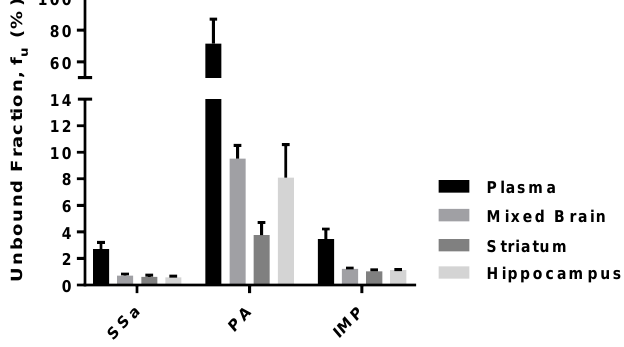
Figure 6. Mean unbound fraction ( f u , %) of SSa, PA, and IMP in rat plasma and brain (mixed brain, striatum, hippocampus) homogenates ( n = 6 each). Vertical bars represent